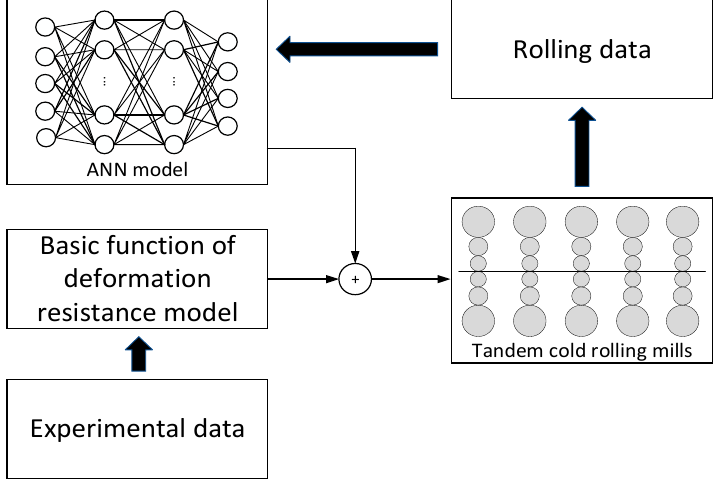
Figure 3. The flow chart of deformation resistance model corrected by ANN.